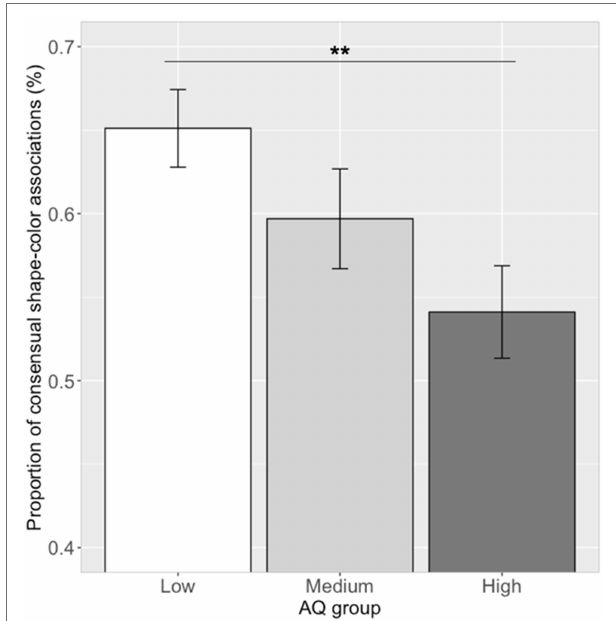
FIGURE 8 | Proportion of consensual shape–color associations in the three groups. Error bar represents the standard mean error. Asterisks indicate significant differences (** p <